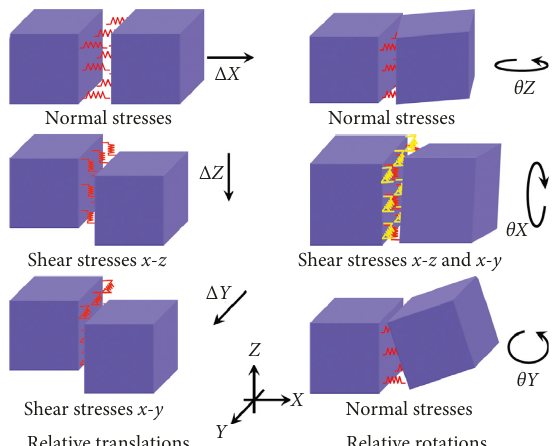
Figure 1: Translational and rotational springs in structure simulation using AEM